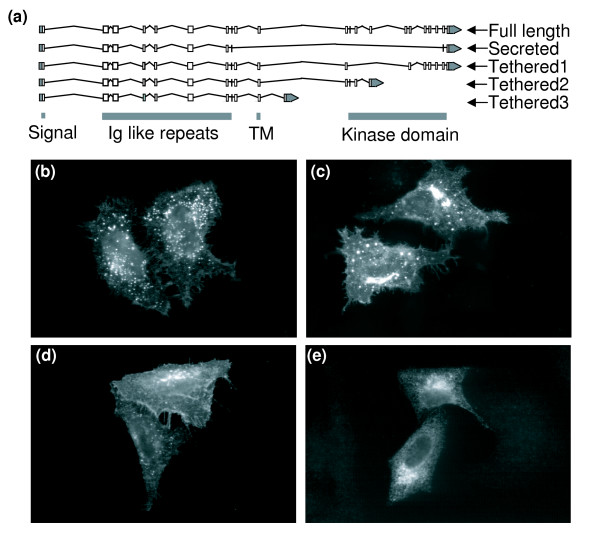
Alternative splice forms of the Csf1 receptor (c-fms). (a) Genomic alignment (mm5; chr18:61616977..61647364) of full-length and variant receptors displaying exon structure and peptide features. Also shown are subcellular localizations of variant receptors transiently expressed in HeLa cells: (b) full-length Csf1r (GenBank:AK076215); (c) Tethered1 (GenBank:AK155565); (d) Tethered3 (GenBank:AK171543); and (e) Secreted (GenBank:AK171241). Tethered forms are produced by exon skipping (Tethered1; c), termination within an intron (Tethered2), and a mutually exclusive alternative 3' exon (Tethered3; d). Tethered forms 1 and 3 exhibit similar localizations to that of the full-length receptor (panel b; cell surface and perinuclear puncta). The form lacking the transmembrane (TM) domain is absent from the cell surface and displays a secretory pathway-like localization.